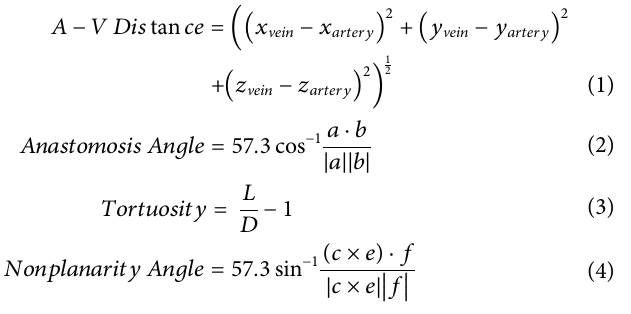
( Figure 2 ). The lumen was smoothed at 60 iterations and a lambda of 0.6. The reconstructed lumen was exported as an STL ASCII format to be used in the Vascular Modeling Toolkit (VMTK) (available at: www.vmtk.org). In VMTK, centerlines were calculated with points at 0.1 mm intervals starting at the